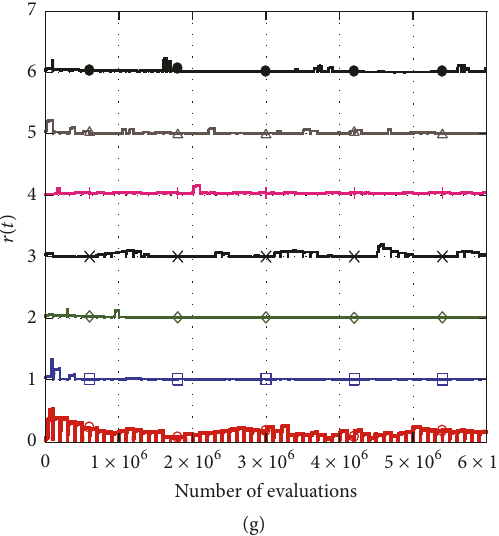
Figure 3: Convergence graph of Basic BA for (a) 𝐹 1 ( 𝑚 = 10 ), (b) 𝐹 1 ( 𝑚 = 50 ), (c) 𝐹 2 , (d) 𝐹 3 , (e) 𝐹 4 , (f) 𝐹 5 , and (g) 𝐹 6 where relative values ( 𝑟(𝑡) ) are presented for each 𝑇 𝑖 as 𝑟(𝑡) + 𝑖 − 1 , where 0 ≤ 𝑟(𝑡) ≤ 1 and 𝑖 = 1, 2,. . . , 7